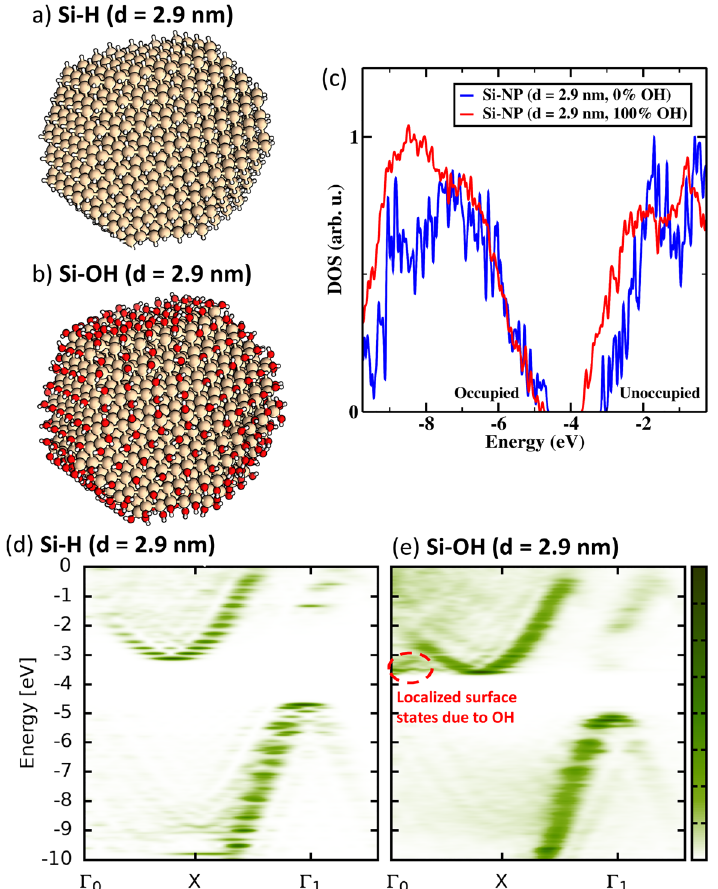
Figure 3. Density of states for pristine Si-NC with 0% OH coverage (blue) and Si-NC with full 100% OH coverage (red) for ( a ) d = 1.8 nm and ( b ) d = 2.9 nm . The DOS is calculated by Gaussian broadening (0.025 eV) and superimposing each discrete molecular energy level.